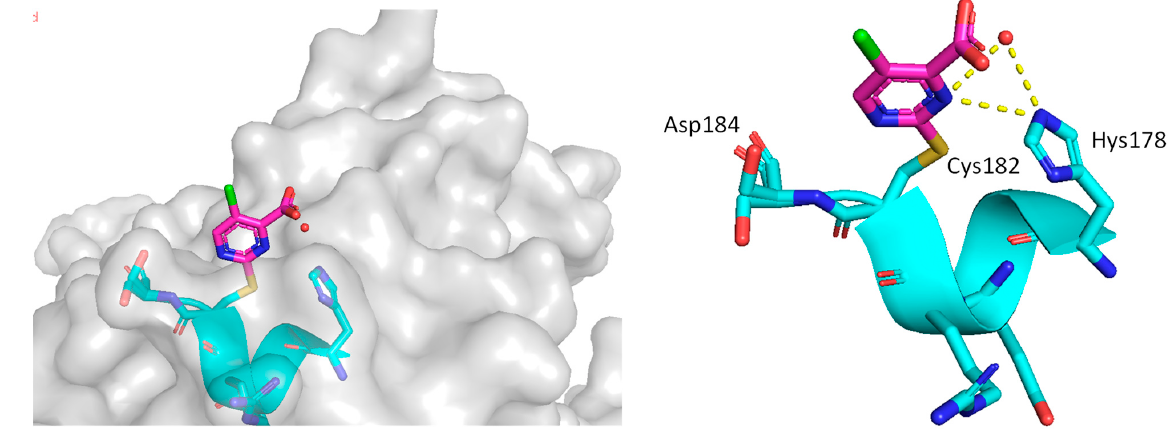
Figure 15. Co-crystal structure of PK11000 covalently bound to Cys182 of a p53 mutant.